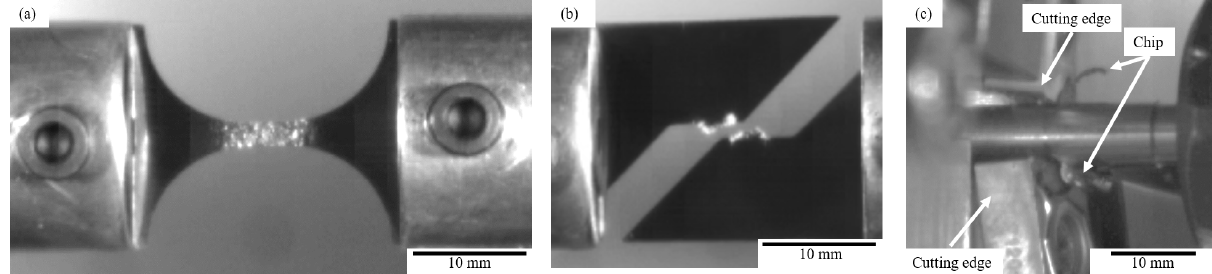
Figure 6. Pictures taken by a high-speed camera during the experiment: ( a ) tensile test, ( b ) shear test, ( c ) cutting